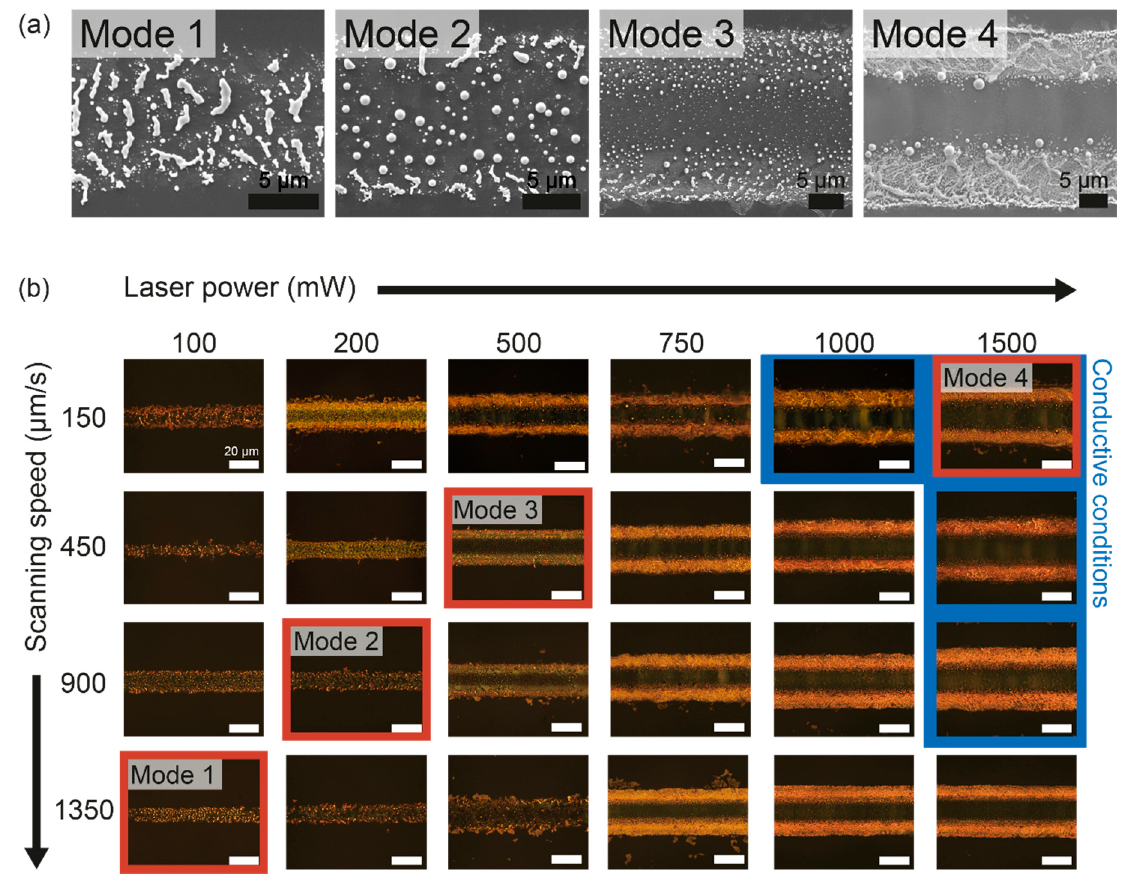
Figure 3. Evolution of the Au pattern depending on the laser intensity: ( a ) representative modes of the results of laser selective refining (SEM images); ( b ) optical images of fabricated Au patterns by the selective laser refining according to laser intensity and resulting thermocapillary force.